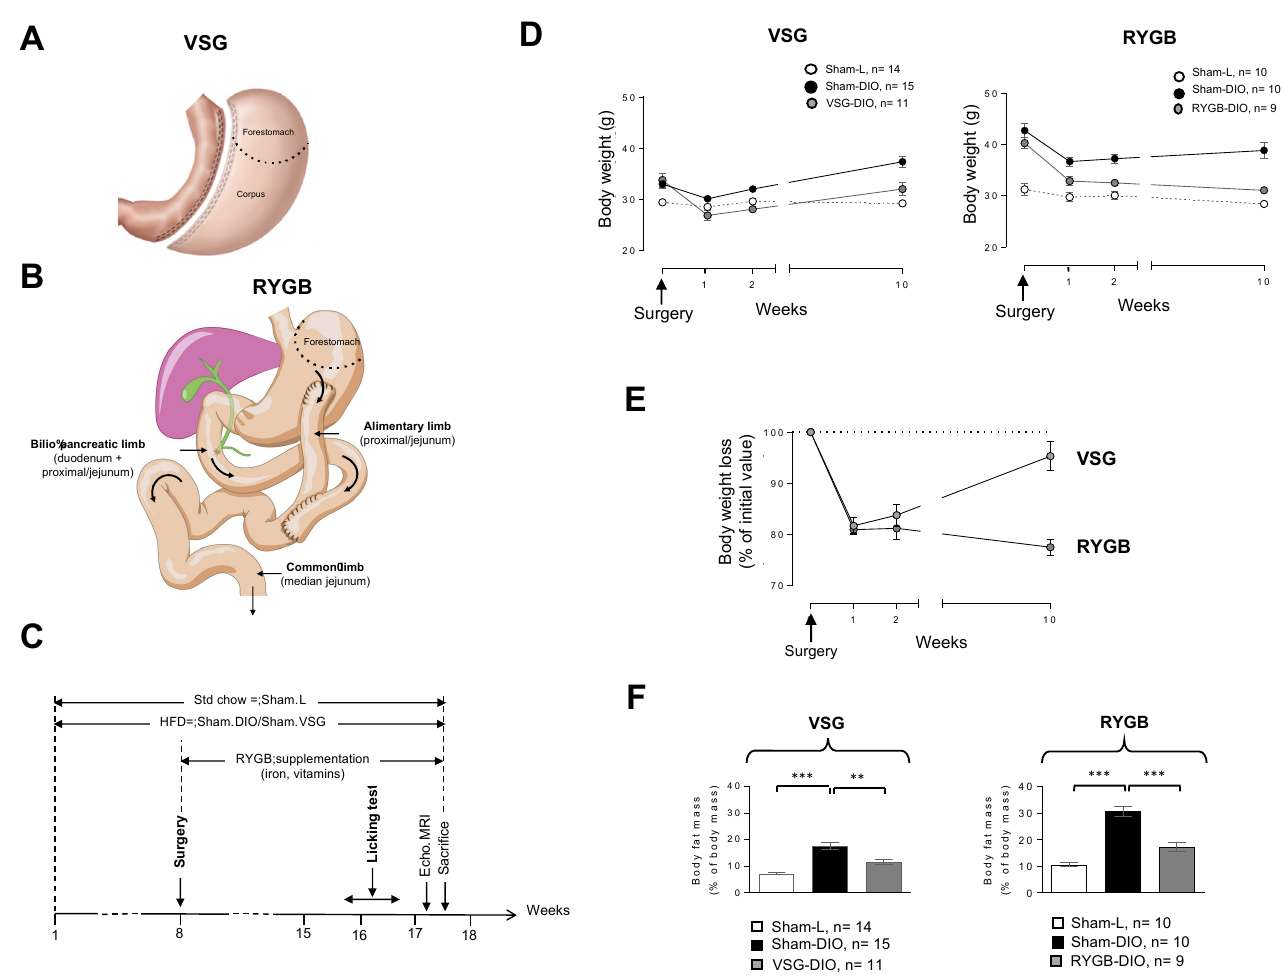
Figure 1. ( A ) Vertical sleeve gastrectomy (VSG) procedure used. ( B ) Roux-en-Y gastric bypass (RYGB) procedure used. ( C ) Time-course of the experiment. ( D ) Evolution of body weight after surgery. ( E ) Evolution of body weight loss after surgery. ( F ) Fat mass at the end of the experiment. Sham-operated lean controls (Sham-L); sham-operated obese controls (Sham-DIO); obese mice that underwent a vertical sleeve gastrectomy (VSG-DIO) or a Roux-en-Y gastric bypass (RYGB-DIO). Mean ± SEM, Wilcoxon and Mann–Whitney tests: ** p < 0.01, *** p < 0.001. Std—standard laboratory chow; HFD—high fat diet; DIO—diet-induced obesity.